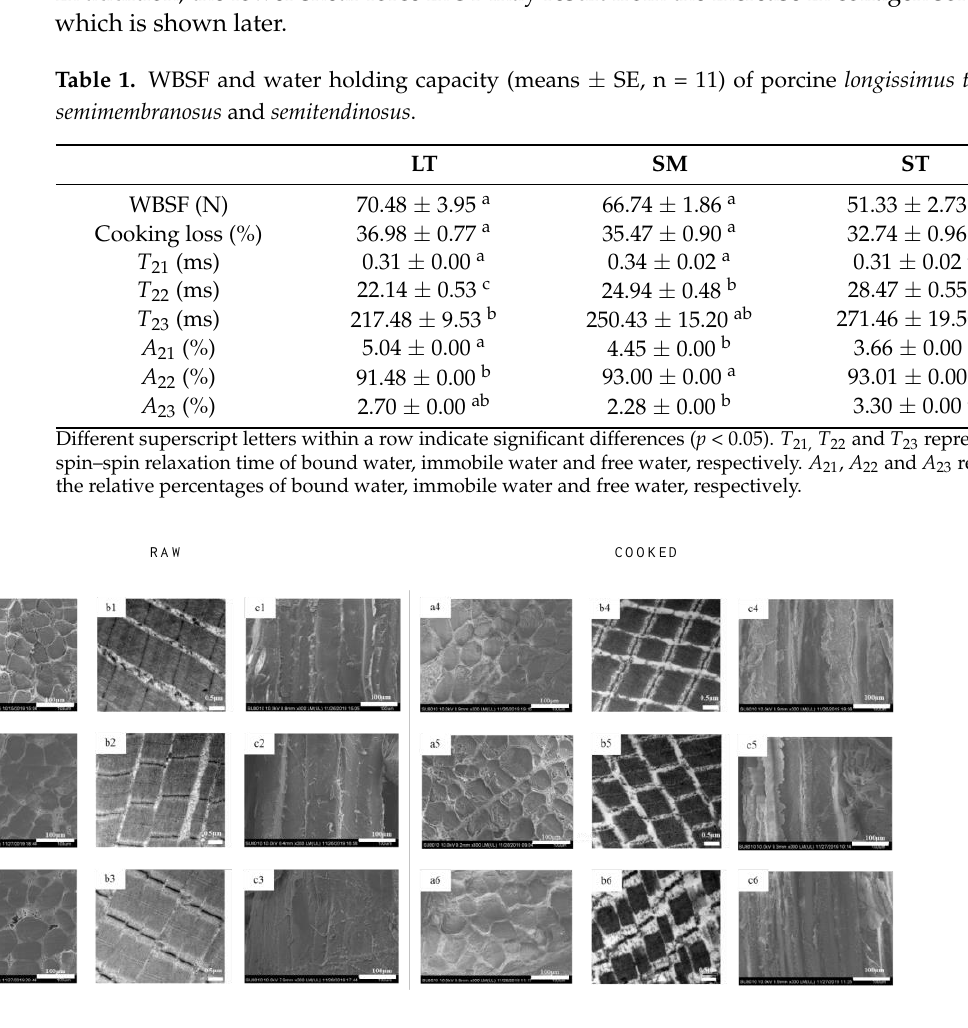
Figure 1. Microstructure and ultrastructure observation of porcine longissimus thoracis , semimembra- nosus and semitendinosus . ( a ) transversal SEM micrographs; ( b ) TEM micrographs; ( c ) longitudinal SEM micrographs; 1, LT; 2, SM; 3, ST. Table 1. WBSF and water holding capacity (means ± SE, n = 11) of porcine longissimus thoracis , sem- imembranosus and semitendinosus .